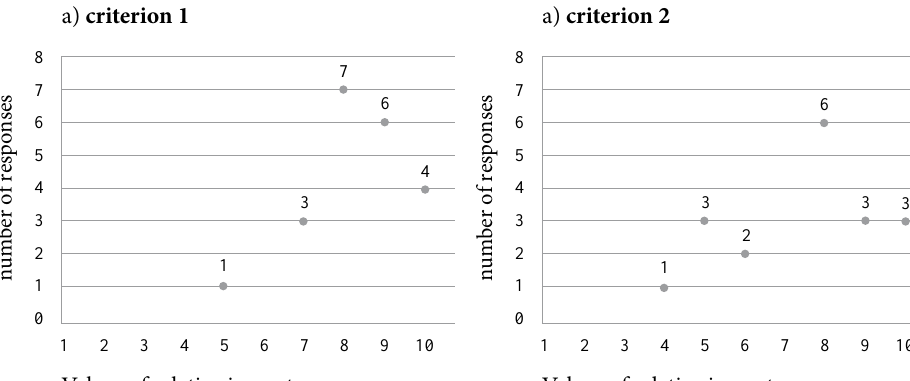
Fig. 1. Diagrams presenting the number of responses attributing particular values of relative impor- tance to the criteria analysed – responses distribution in a given sample; a) for criterion 1; b) for criterion 2 (only 2 basic criteria were